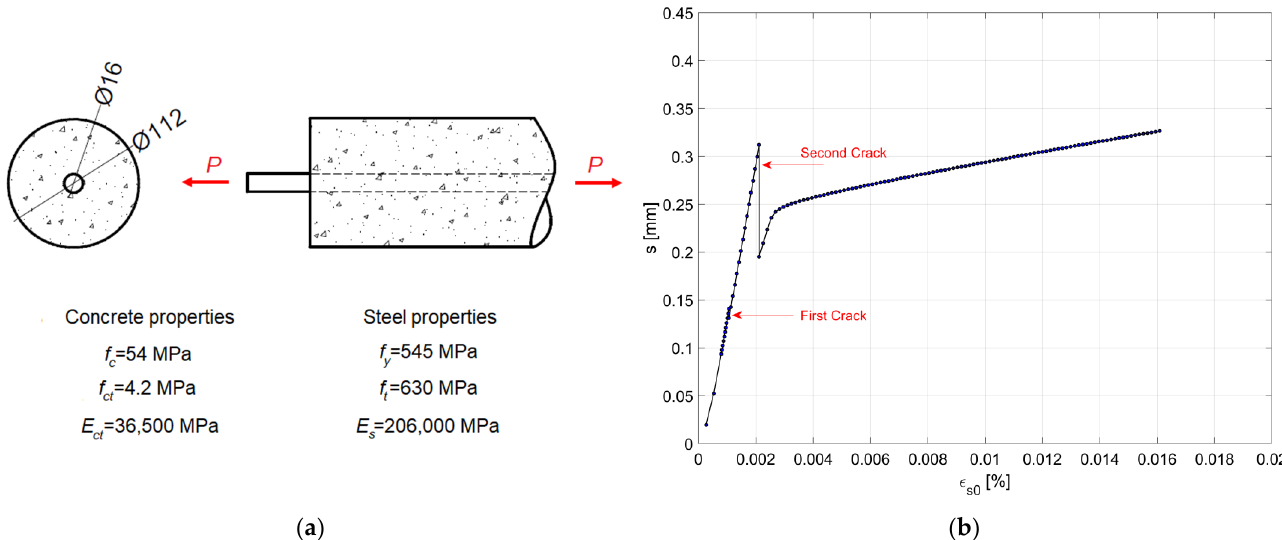
Figure 3. Example of the implementation of the procedure: ( a ) reinforced concrete cylindrical tie under axial load P and experimental materials properties (unit: mm); ( b ) resulting slip s -strain ε s 0 diagram considering the CEB bond–slip model.